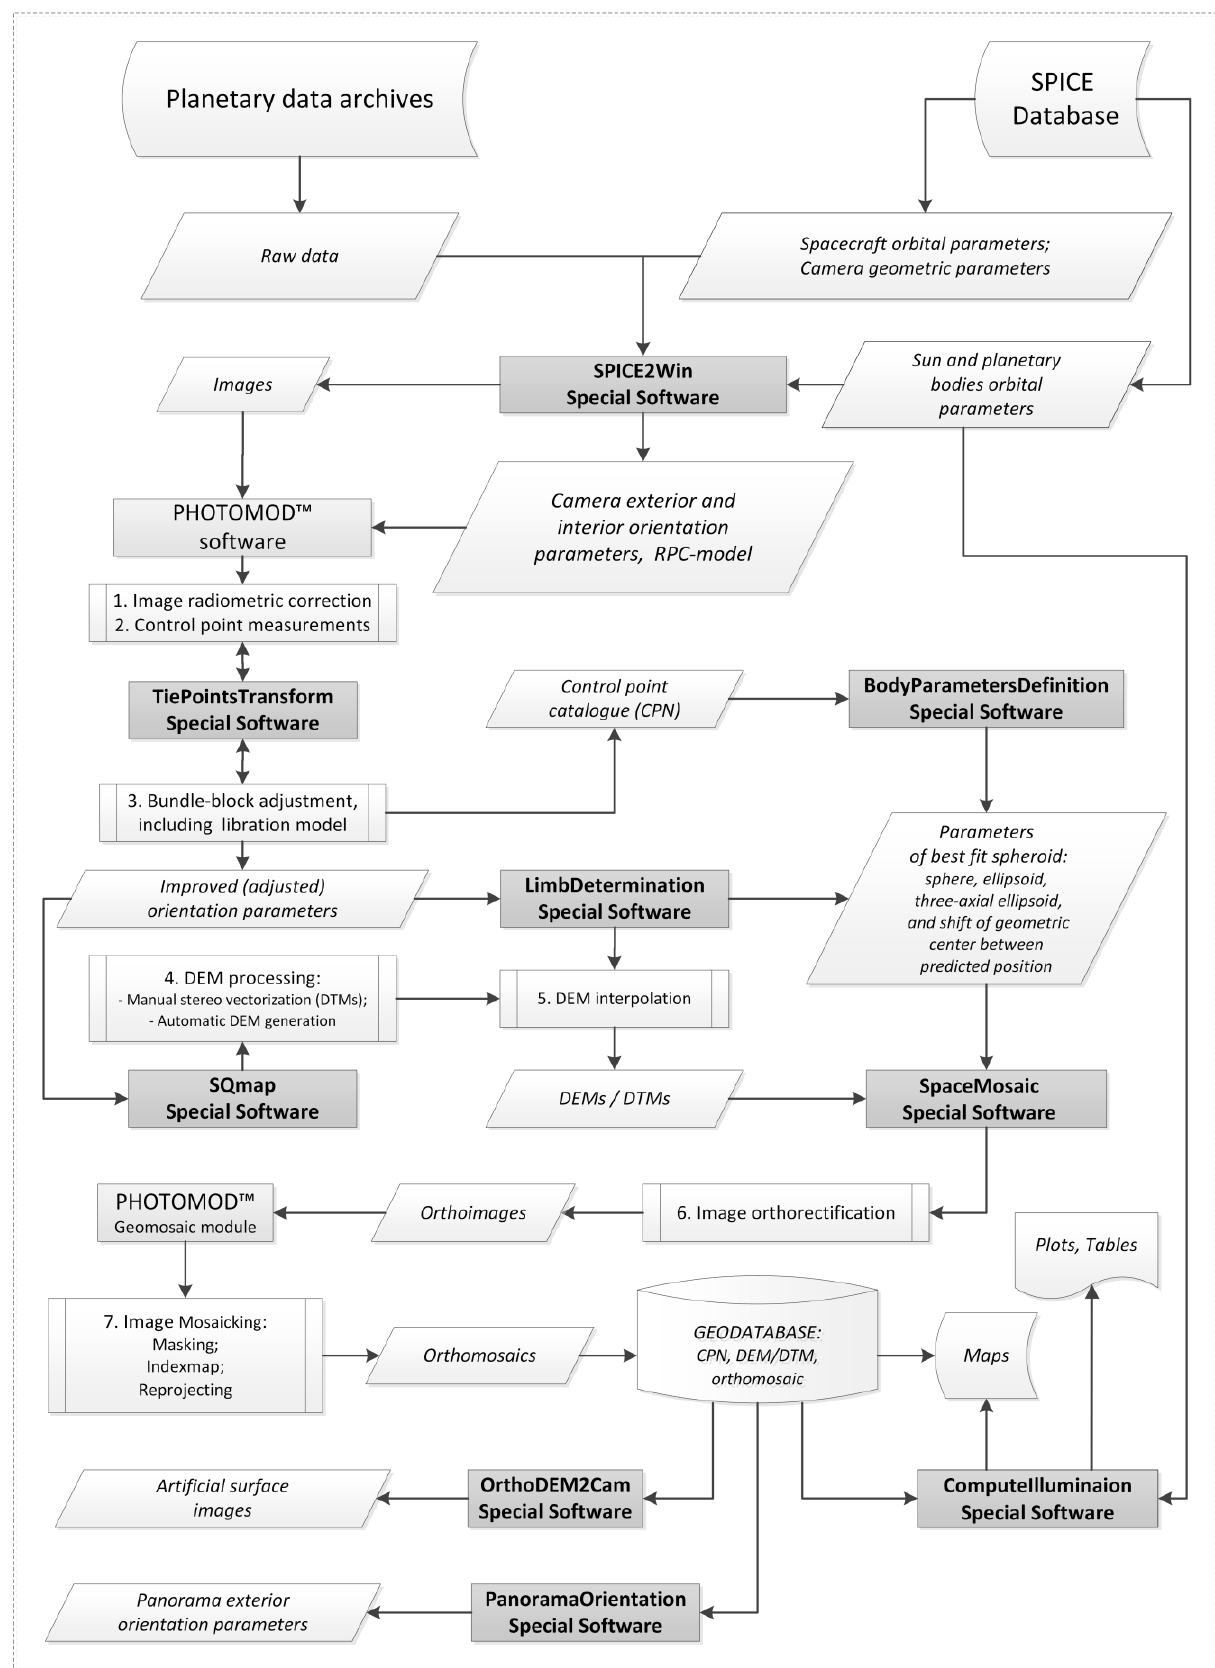
Figure 1. The flowchart of photogrammetric image processing of planetary data based on special developed software and